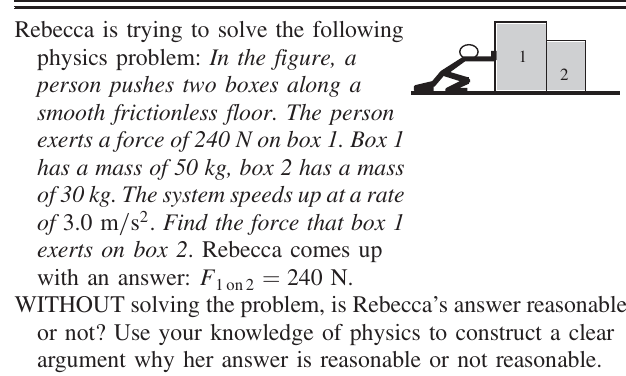
TABLE II. An example of a problem that engages the ability to evaluate a